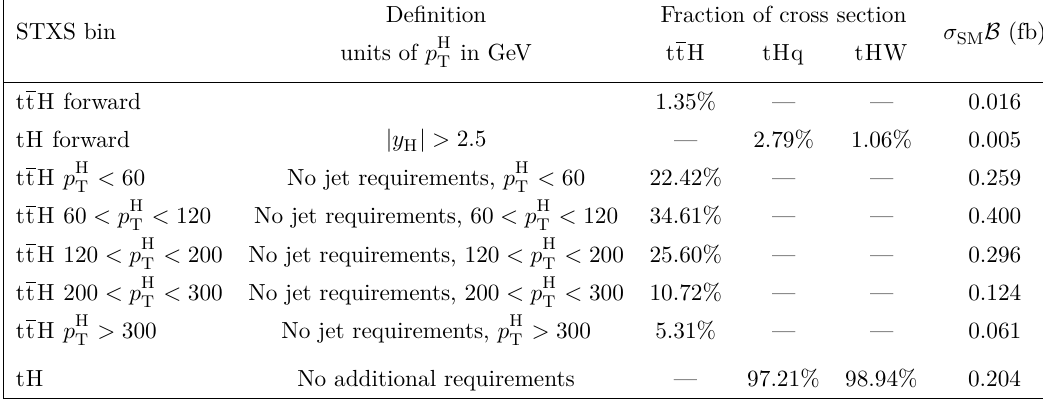
√ = 125 GeV, is given for each bin in the s = 13 TeV and m H | < 2 . 5 . Events with | y | > 2 . H H